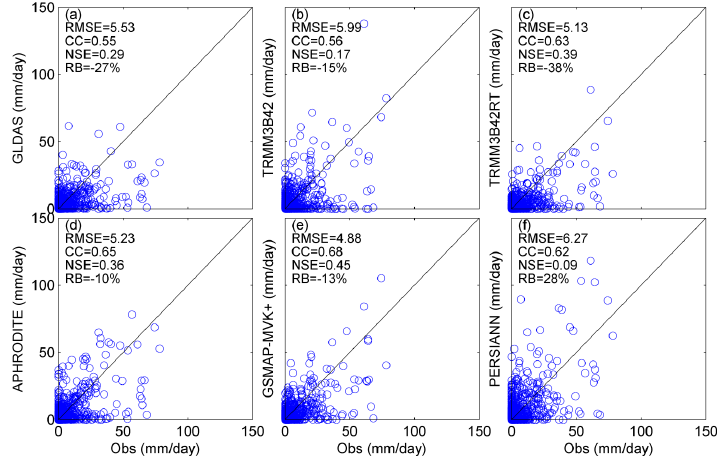
Figure 3. Scatter plots of basin-averaged precipitation products versus gauge observations at a daily scale.